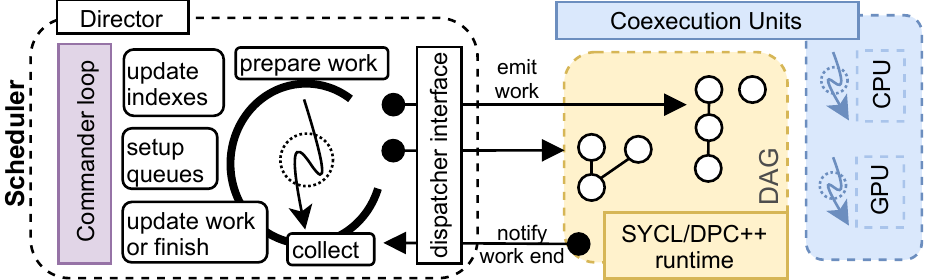
Figure 4. A Commander’s loop where the scheduling strategy is performed to coordinate the behaviors of the Coexecution